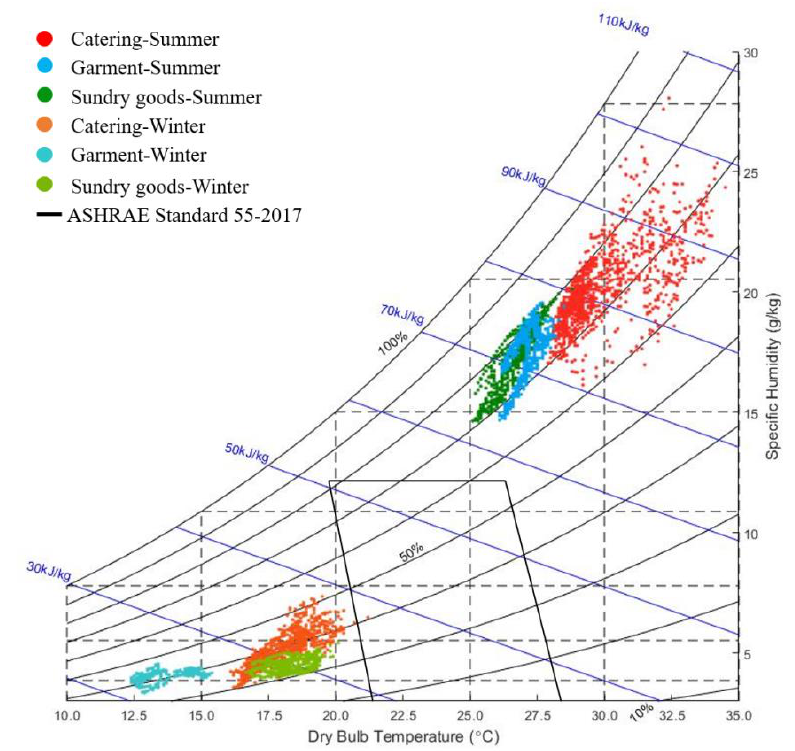
Figure 13. Distribution of air-state points in a psychrometric chart.